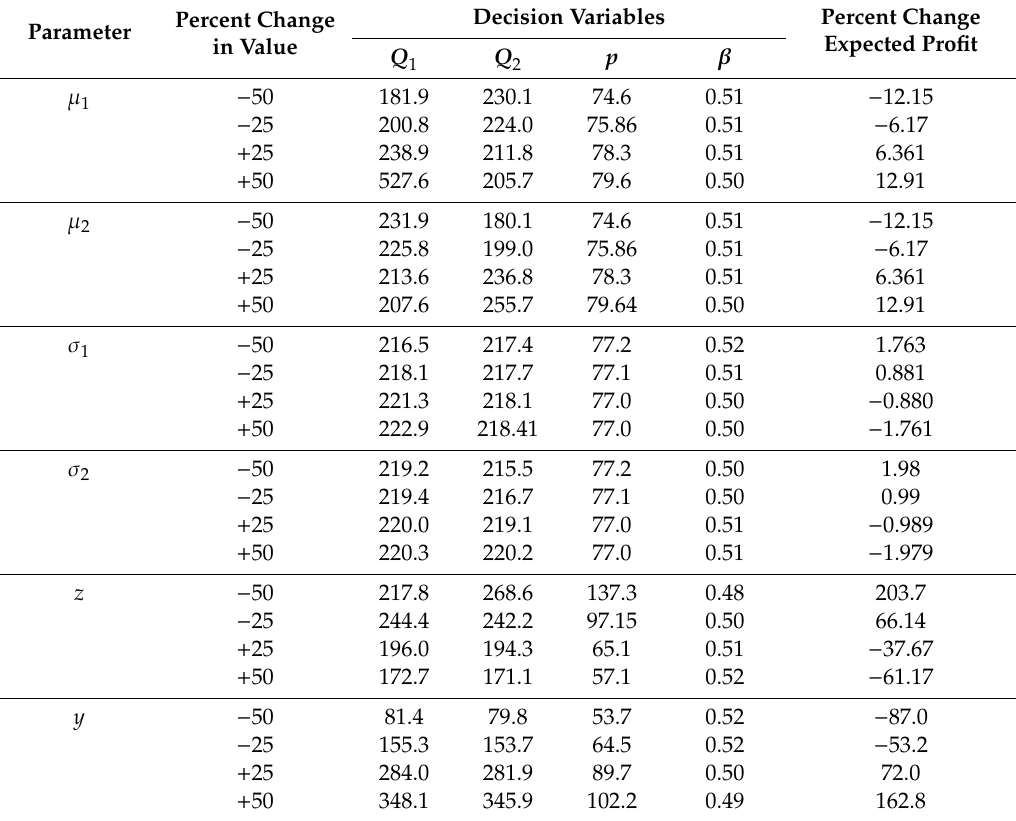
Table 3. Sensitivity analysis for the demand